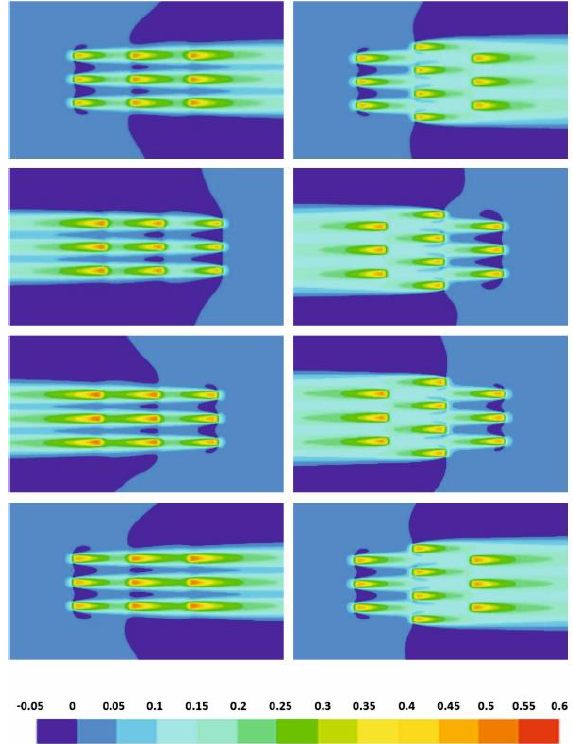
Figure 7. Isocontour of velocity deficit in the case without incidence (RWOI) in a tidal farm with an aligned (left) and a staggered layout (right) for time 1.22 h (R1), 4 h, 6.22 h (R2), and 12.25 h (R1).